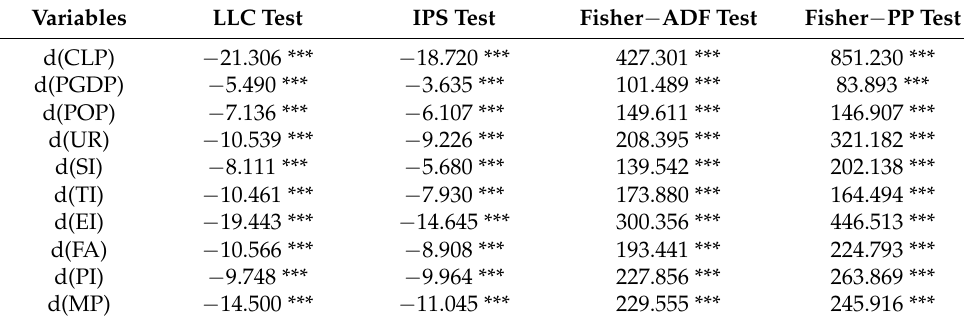
Table 5. Results of unit root